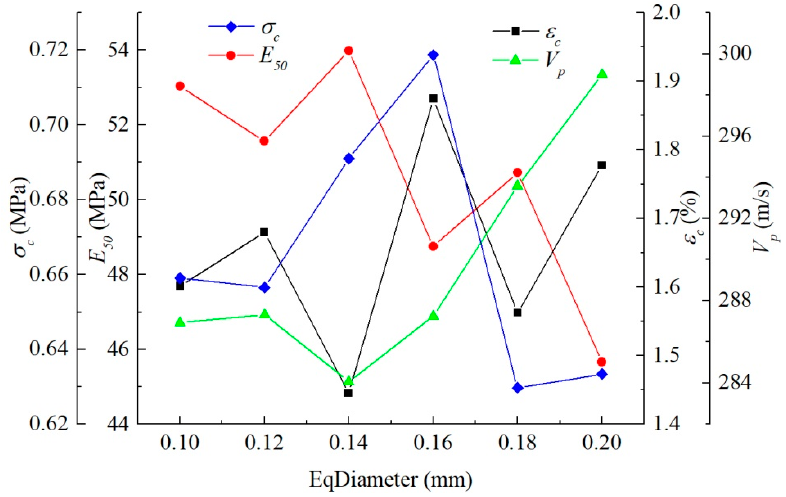
Figure 16. Relationship between pore equivalent diameter and macroscopic static and dynamic